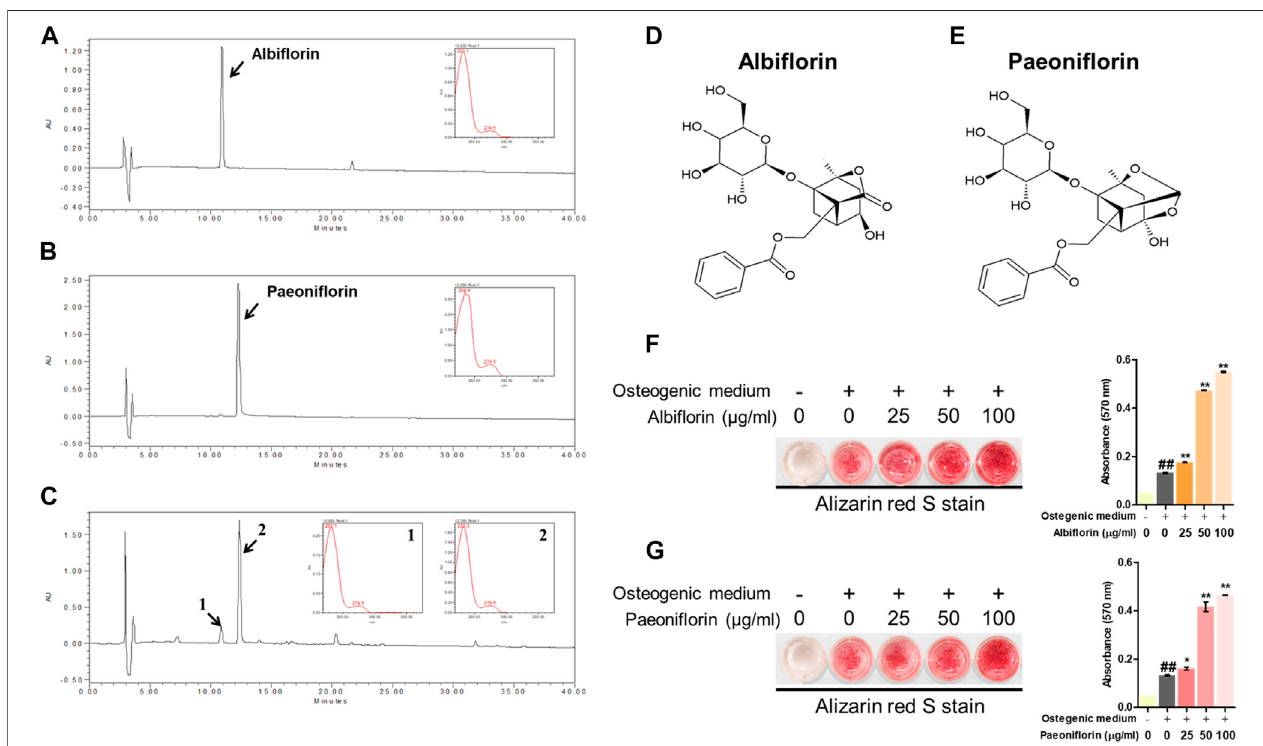
FIGURE 4 | HPLC of. (A) albi fl orin, (B) paeoni fl orin, and. (C) PL. Each standard peak was detected at 232 nm. Molecular structure of (D) albi fl orin and (E) paeoni fl orin. (F) and (G) AlizarinredSstainingwasusedtoanalyzetheeffectsofalbi fl orinandpaoni fl orinoncalci fi ednoduleformation.Theseresultsarepresentedasthe mean ± SEM ( n (cid:2) 3 for each experimental). ## p < 0.01 vs. growth medium cells; ** p < 0.01, * p < 0.05 vs. osteogenic medium